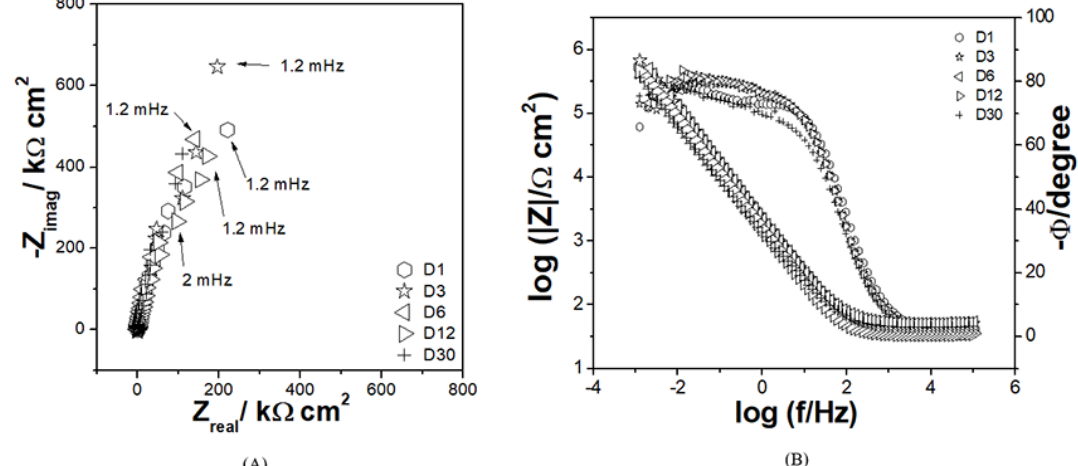
Figure 5. Experimental complex plane and Bode plots for bare substrate in non-aerated and unstirred Hanks' solution without BSA for 30 days of immersion at 37 ºC: (A) complex plane plots; (B) Bode - phase angle vs . log f and impedance modulus vs . log f